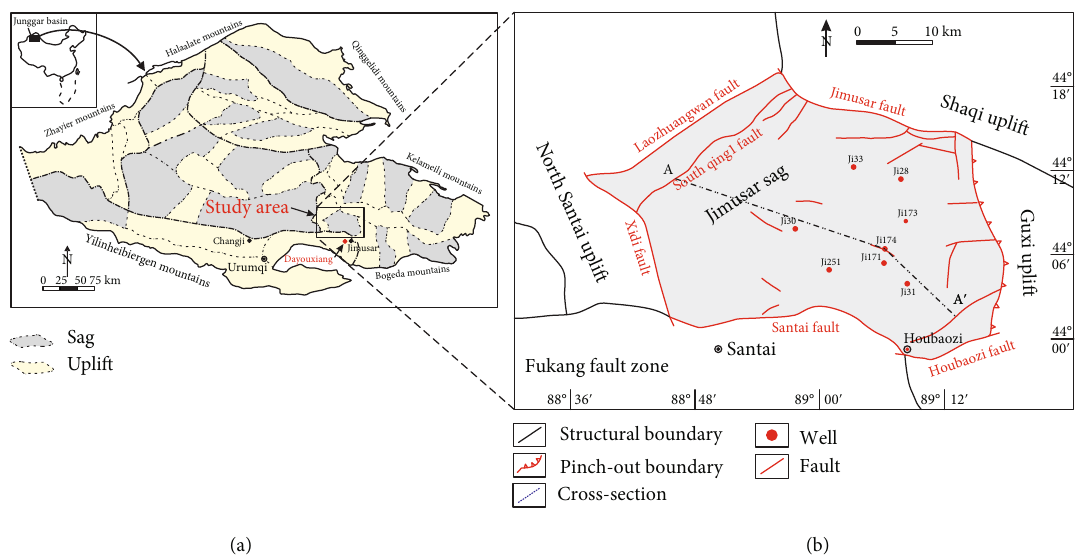
Figure 1: (a) Location map of the Jimusar sag and (b) structure contour map of the top of the Lucaogou Formation. Line A – A ’ represents the location of the seismic section in Figure